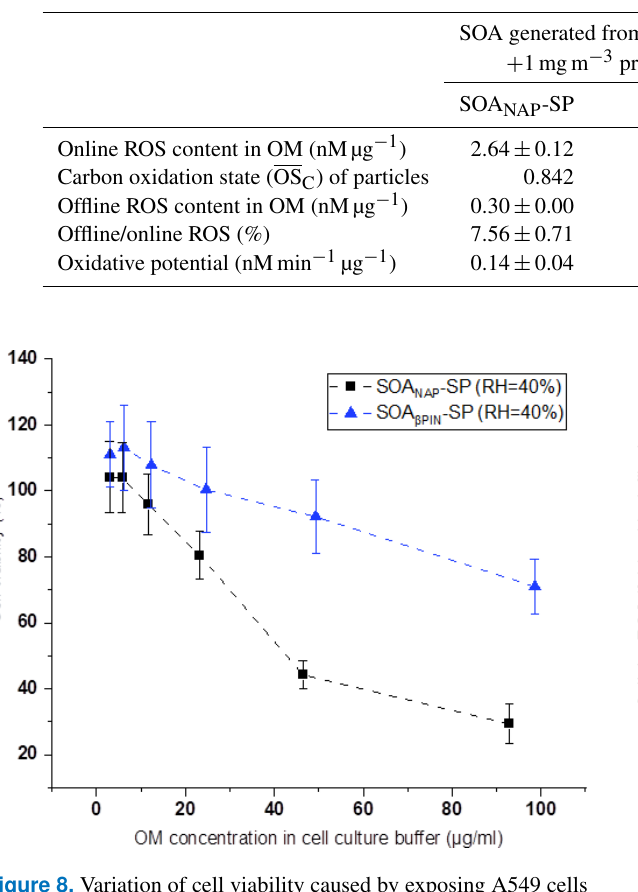
Figure 9. Fold changes of cellular ROS production in A549 cells after exposure to particle extracts. Exposure of the A549 cells in the particle extracts led to a significant increase in the fold change of cellular ROS production compared to blank filter extracts. At a similar exposure dose, SOA NAP -SP SOA led to a much higher fold change of cellular ROS production than SOA β PIN -SP